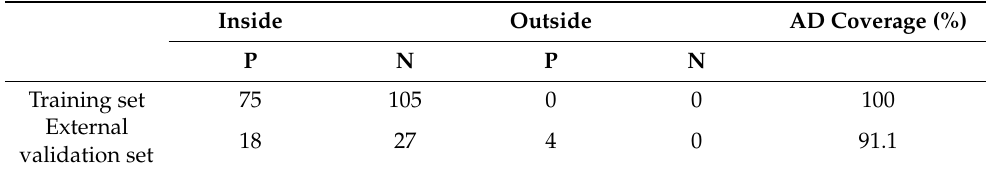
Table 5. Number of drugs inside and outside of the